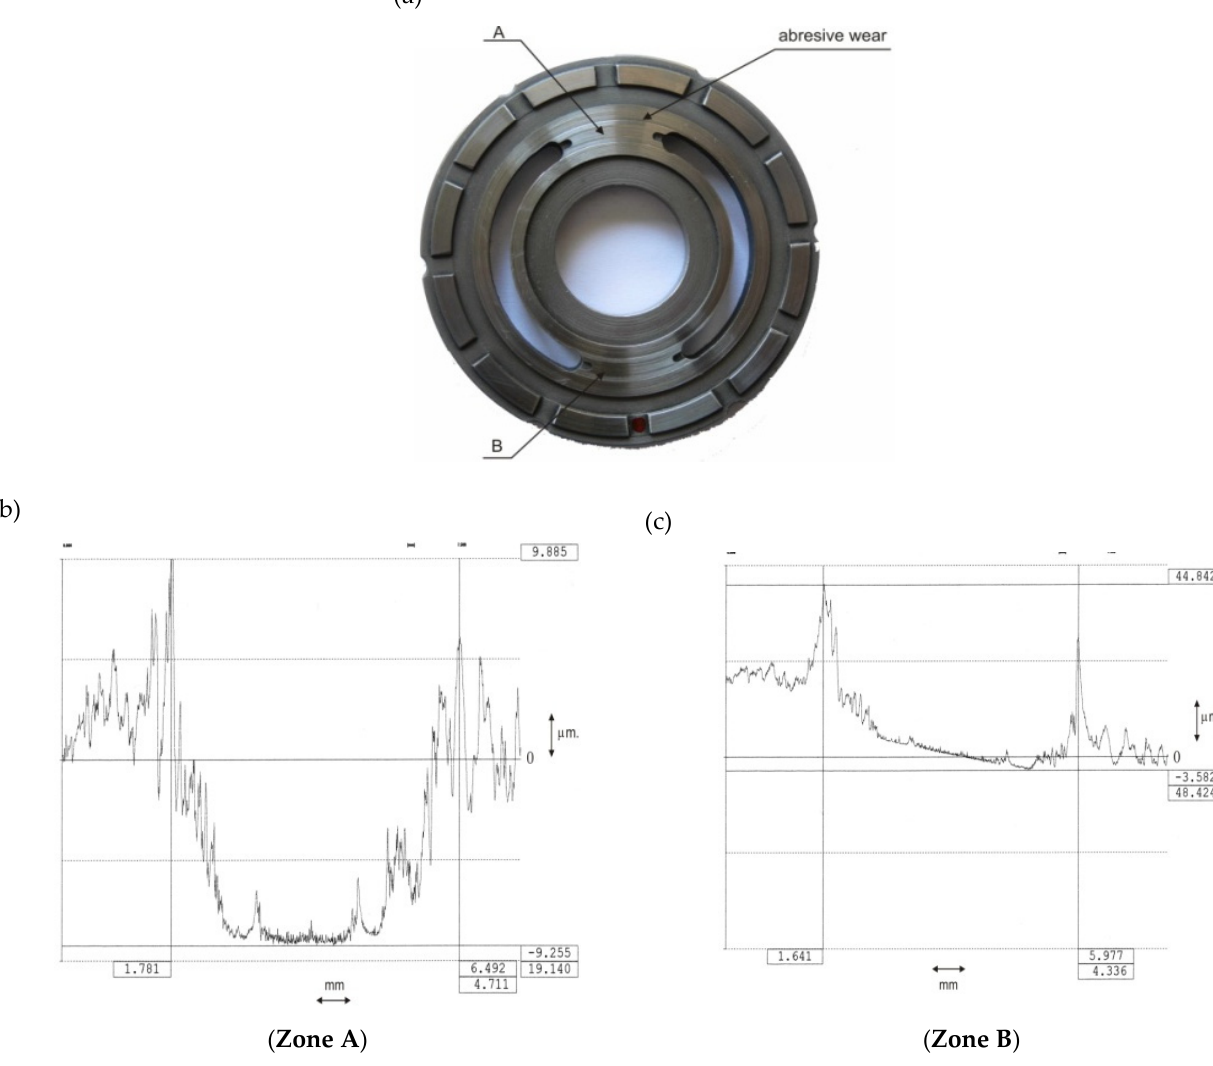
Figure 4. View of the worn valve plate surface and the wear profiles of the transition zones: ( a ) valve plate, ( b ) zone A wear profile, ( c ) zone B wear profile.